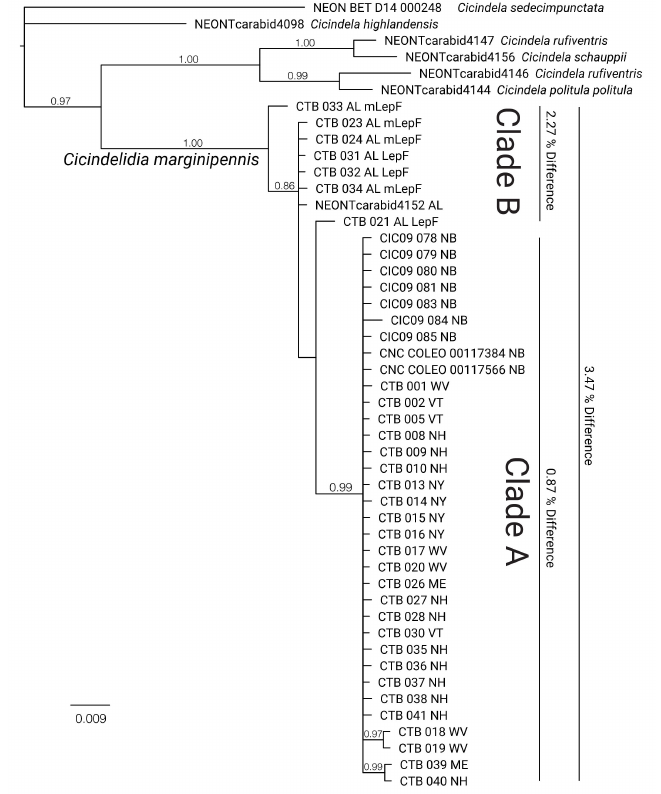
Figure 5. COI Bayesian genealogy showing accession numbers and abbreviations for state / province for all C. marginipennis specimens in this study, rooted using closely related species. Clades A and B show specimens that directly correspond to the same clades indicated in the COI haplotype network of Figure 3. Percent % di ff erences shown on the small inner bars are calculated from within those clades. Percent di ff erence on the large outer bar is calculated between Clades A and B. Posterior support values for each node appear at the base of that node. The scale bar represents estimated substitutions per